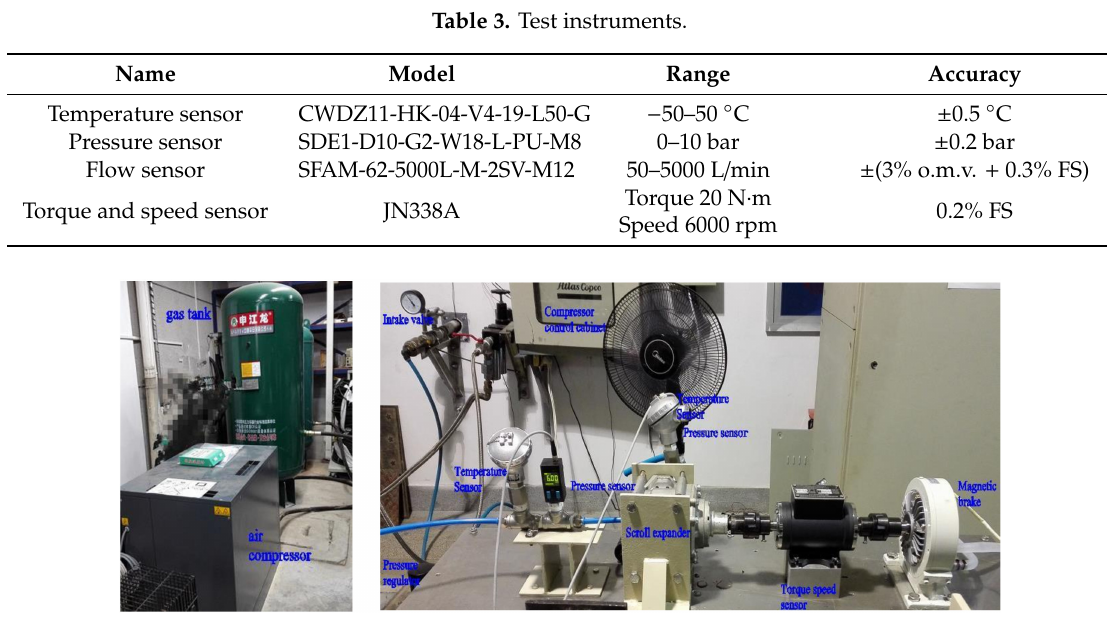
Figure 3. Experimental platform of compressed air energy storage system.